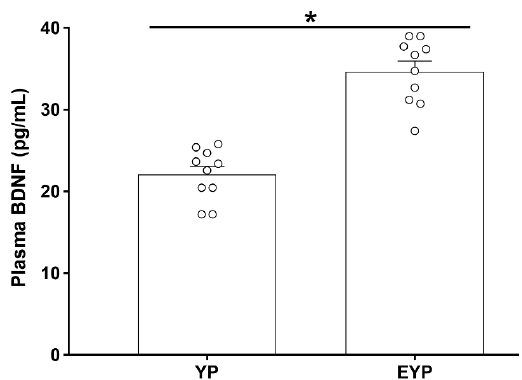
Figure 1. Effect of exercise on plasma brain-derived neurotrophic factor (BDNF) in donation plasma mice. YP: young plasma, EYP: exercised young plasma. Data are expressed as the mean ± standard error of the mean (SEM). * p < 0.05 .